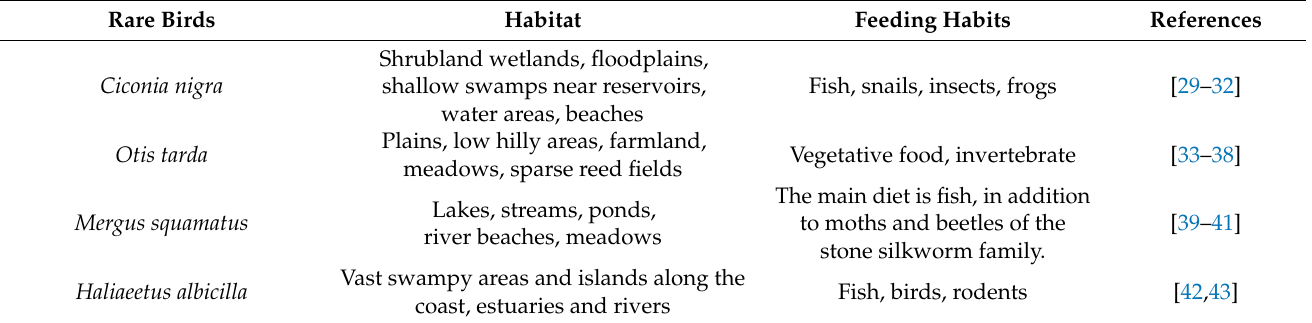
Table 2. Statistics of habitat and foraging preferences of rare